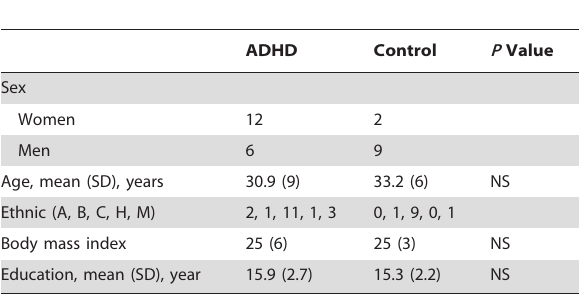
Table 1. Clinical characteristics of control subjects and ADHD